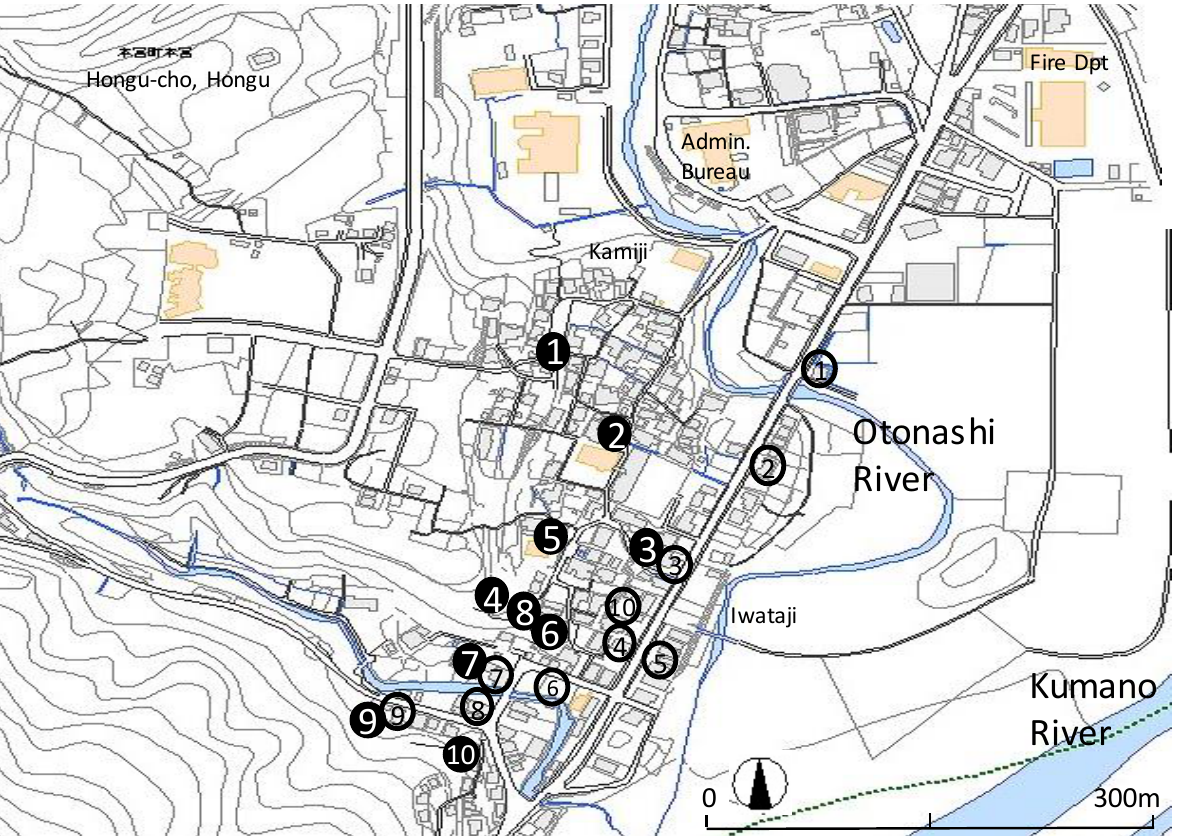
Figure 9. Location of Agariyas and residences in Hongu (Black circles show Agariyas and white circles are houses/shops). No.